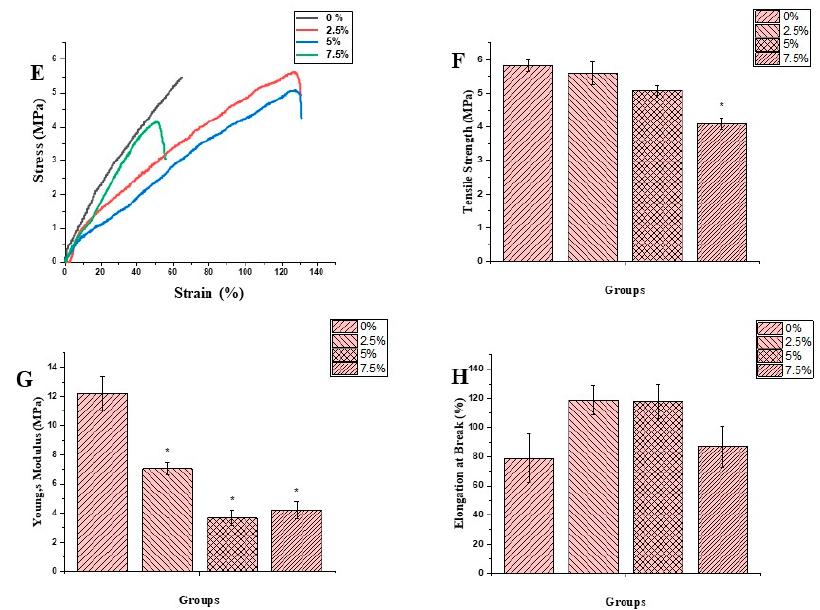
Figure 3. Stress-Strain curve, Tensile Strength, Young’s Modulus and Elongation at break for Dry Figure 3 ( A – D ) and Wet Figure 3 ( E – H ) respectively. (* = significance difference in comparison with